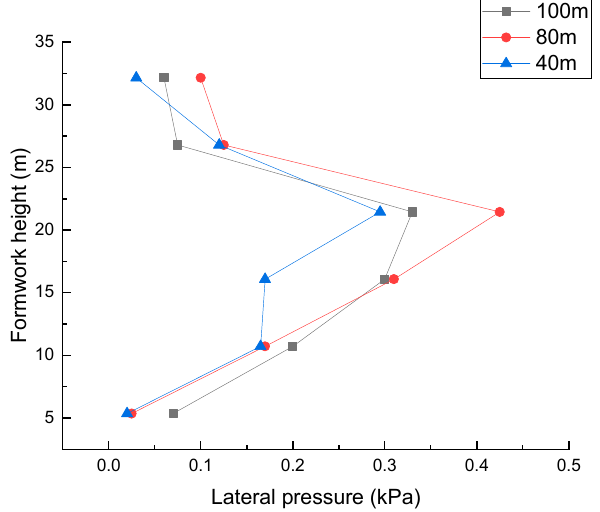
( c ) Figure 5. Effect of the number of casts on lateral pressure at depths of 100 m, 80 m and 40 m. ( a ) The depth of the measurement point is 100 m; the red dots indicate the casting period (fourth to ninth cars), and the blue dots indicate the period between casts. ( b ) The depth of the measurement point is 80 m; the red dots indicate the casting period (6th to 13th cars), and the blue dots indicate the period between casts. ( c ) The depth of the measurement point is 40 m; the red dots indicate the casting period (14th to 19th cars), and the blue dots indicate the period between casts. Figure 5 shows that all four casts before reaching the peak caused an increase in lat- eral pressure, which subsequently decreased due to hardening. The increase in lateral pressure at different heights lasted for about 2.5 h, whereas a decrease occurred rapidly for the next 0.5 h, after which the lateral pressure plateaued. The height corresponding to each cast can be calculated based on the volume of concrete loaded in each mixer truck and the area of the slot. If the height required for each measurement point from the begin- ning of the change in lateral pressure to the peak is defined as the characteristic height, the characteristic height can be calculated as approximately 21 m. As shown in Figure 6, the lateral pressures at each of the three measured points were measured after the lateral pressure exceeded the respective hydrostatic pressure. Interest-